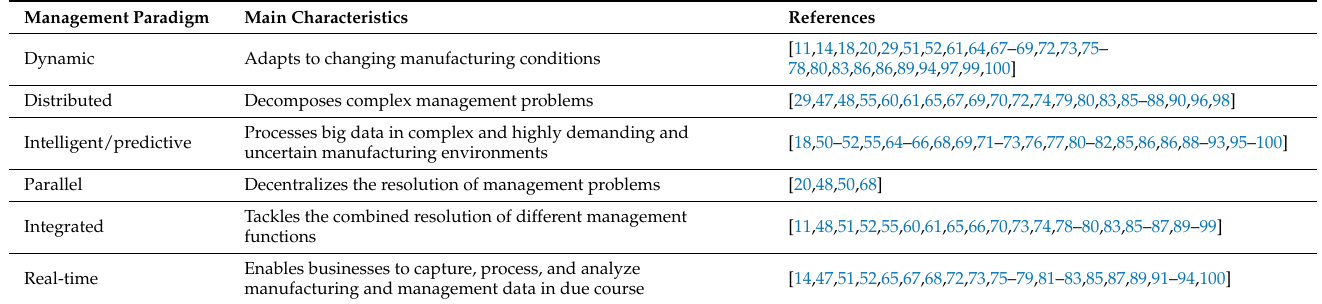
Table 3. Main characteristics underlying the proposed six management